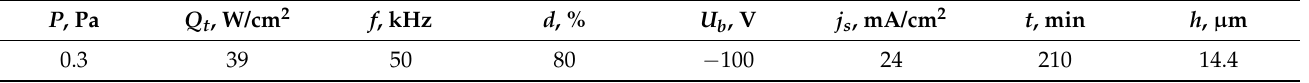
Table 1. Deposition parameters of Cr